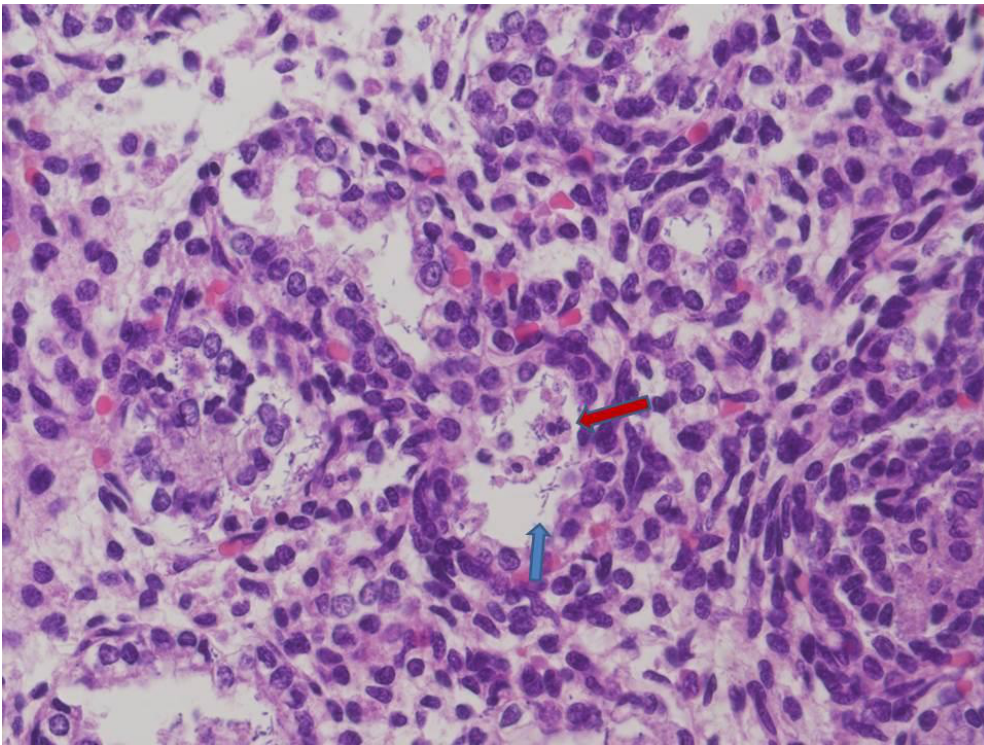
Figure 1. Fetal lung: a few intra-alveolar neutrophils (red arrow) associated with rod-shaped bacteria (blue arrow) (HE staining 20×). Microorganisms 2021 , 8 , x FOR PEER REVIEW